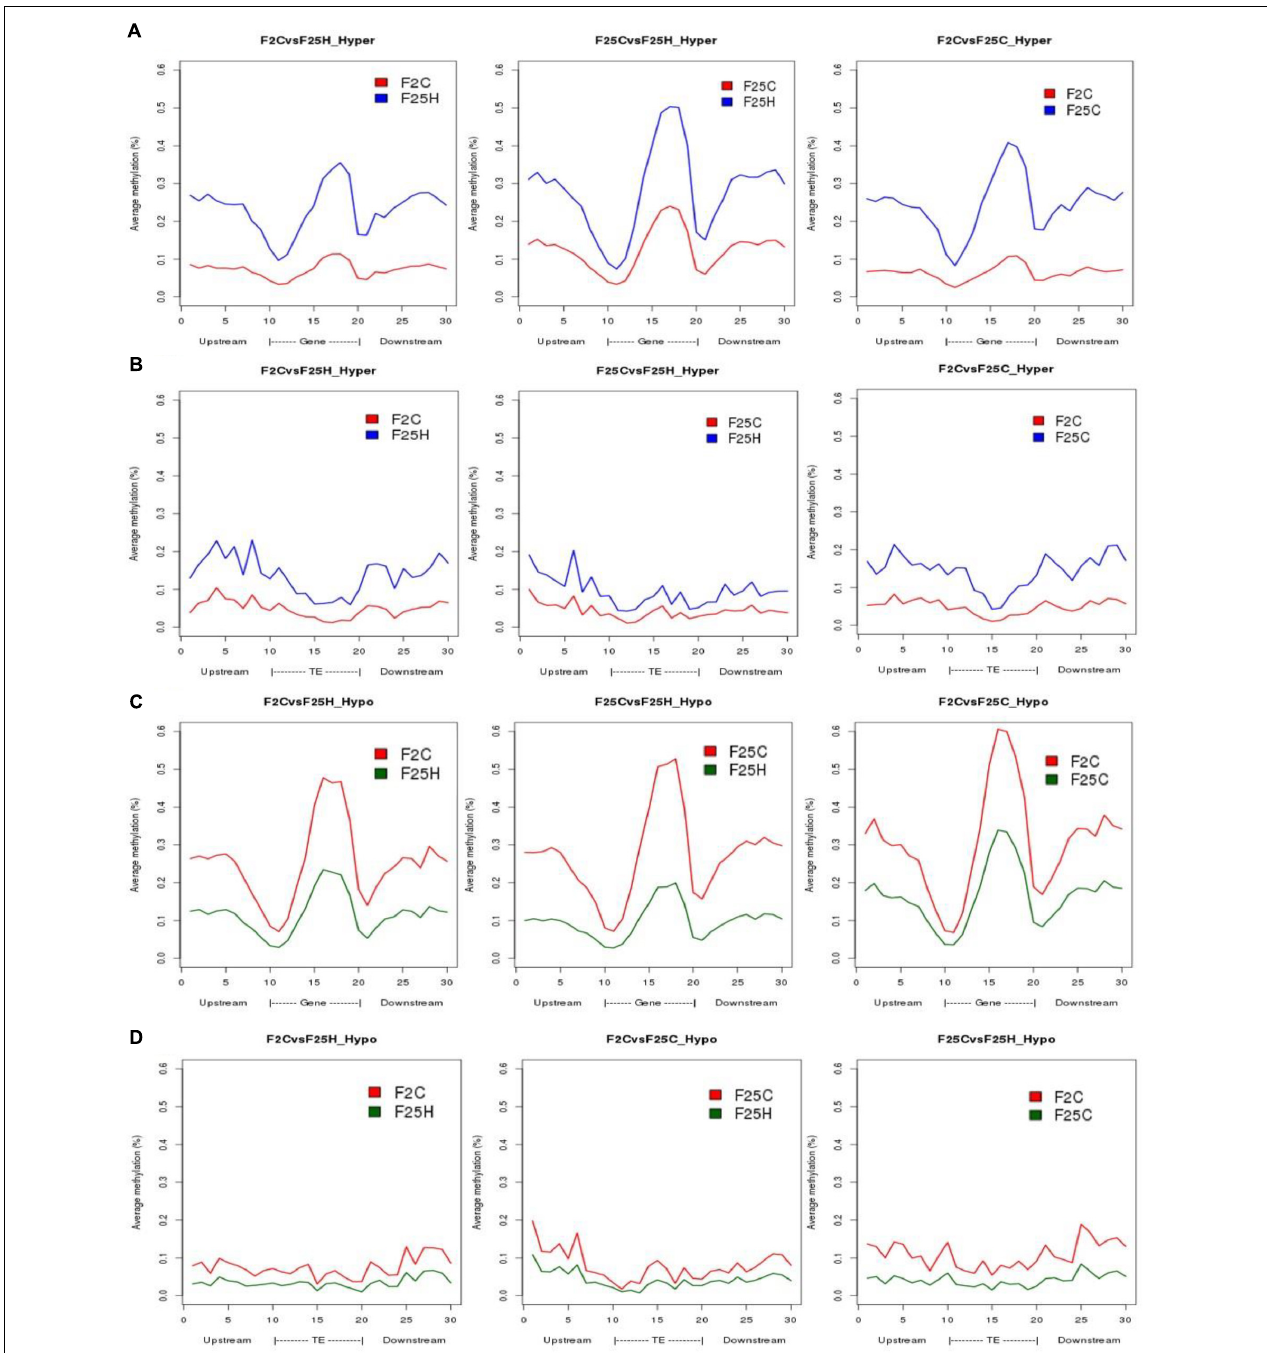
FIGURE 6 | The distribution of hyper-and hypo-methylated CG-DMRs in the gene body and TEs in F25H vs. F2C, F25H vs. F25C, and F25C vs. F2C comparison groups. (A) Distribution of hypermethylated CG-DMRs in gene bodies. (B) Distribution of hypermethylated CG-DMRs in TEs. (C) Distribution of hypomethylated CG-DMRs in gene bodies. (D) Distribution of hypomethylated CG-DMRs in TEs.